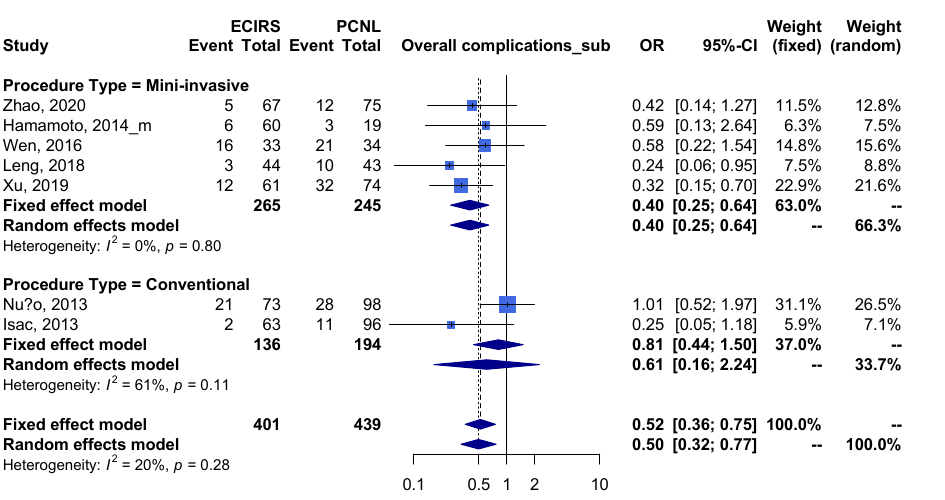
Figure A3. Subgroup analysis of outcome regarding overall complications. (Mini: [17–19][22,23]; Conventional: [20,21]).